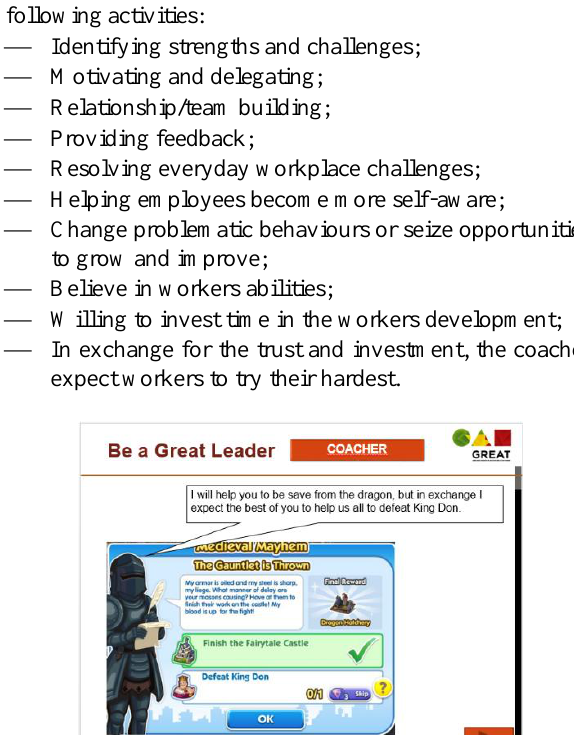
Figure 4. Leader – Change